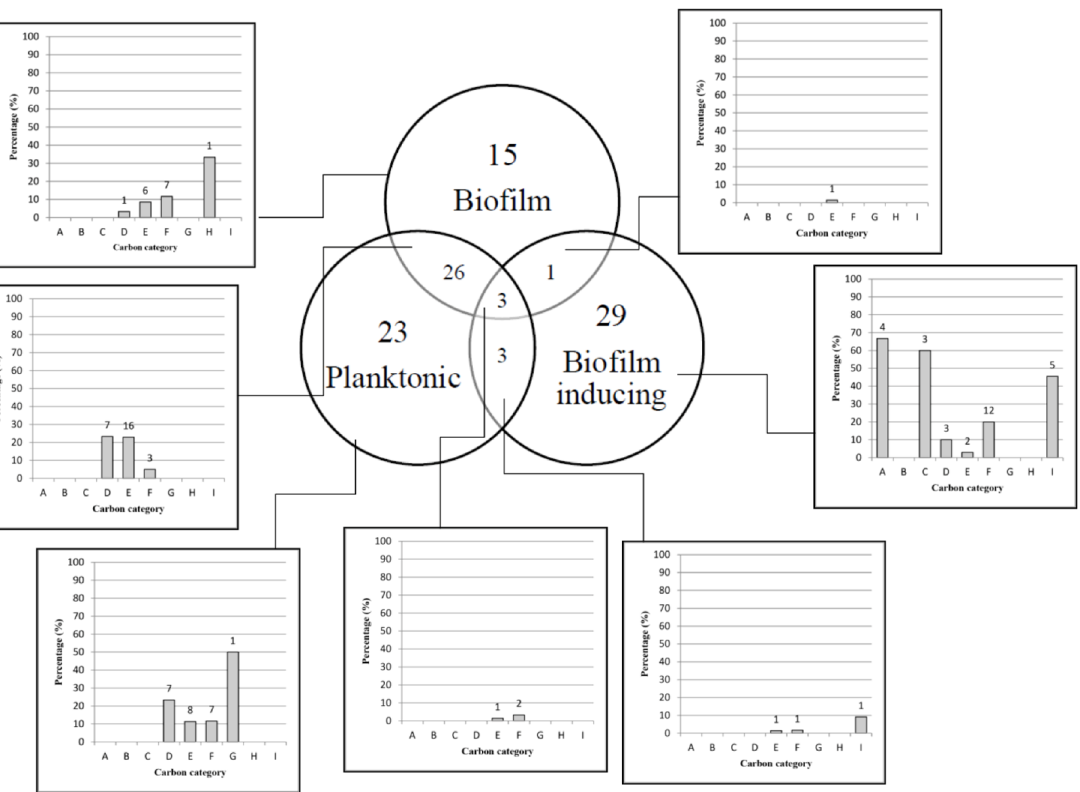
Fig 1. Venn diagram showing carbon substrates catabolised by S . Typhi human carrier strain CR0044 in 3 different bacterial growth stages; planktonic, biofilm and inducing transition of planktonic cells to form biofilm. A total of 190 carbon substrates were tested. A: Alcohol, B: Amide, C: Amine, D: Amino acid, E: Carbohydrate, F: Carboxylic acid, G: Ester, H: Fatty acid, I: Polymer. Y-axis indicates the percentage of carbon utilized in planktonic, biofilm and biofilm inducing S . Typhi bacterial growth stages. X-axis shows the carbon category for each carbon substrate tested. The Venn diagram was obtained based on the Average Growth Curve (AUC) area and was classified into a combination of 6 different bacterial growth stages: growth only in planktonic; only in biofilm; inducing biofilm formation; planktonic and biofilm only; planktonic and inducing biofilm formation only; biofilm and inducing biofilm formation only; all 3 stages of bacterial growth planktonic, biofilm and inducing biofilm formation. S . Typhi biofilm growth stage was tested using the 96-well peg lid on Phenotype MicroArray plate for 48 h. The biofilm inducing experiment was conducted using 0.5% crystal violet stain and absorbance was measured at wavelength OD 590nm every 6 h.